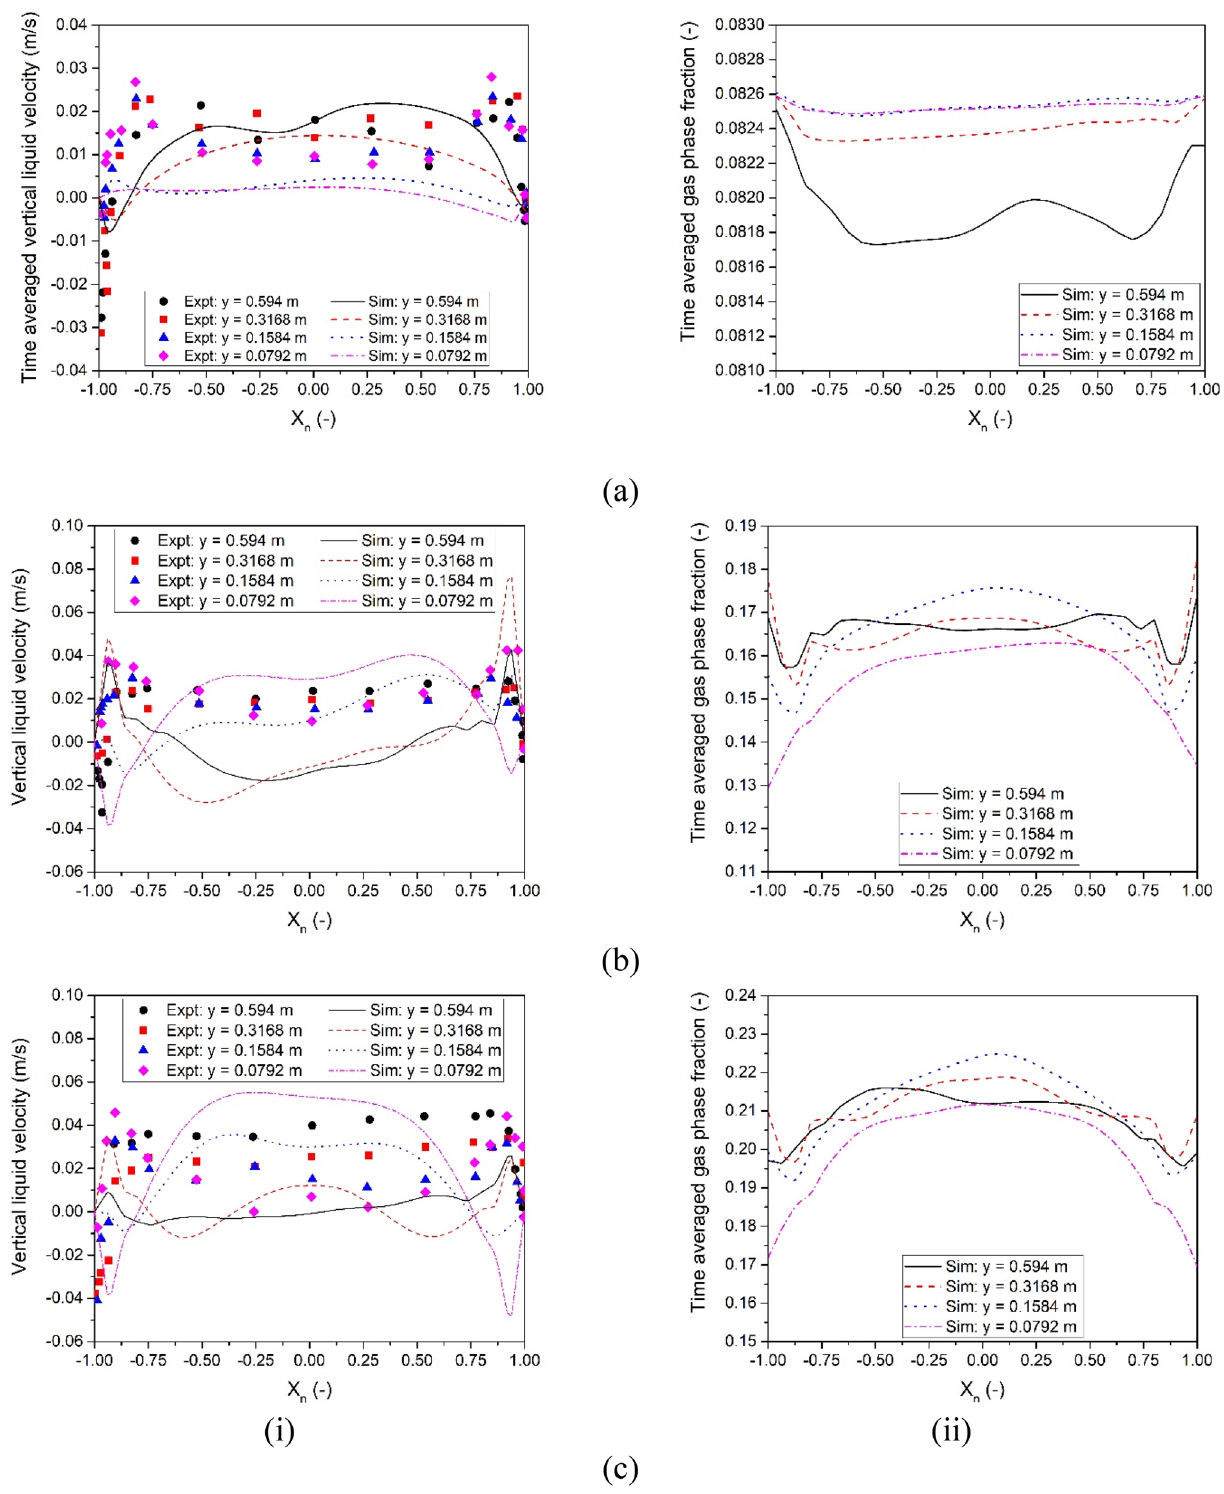
Fig. 12 Time-averaged (i) vertical liquid velocity and (ii) gas volume fraction distribution at different superficial gas velocity a 2.9 cm/s, b 4.3 cm/s and c 5.8